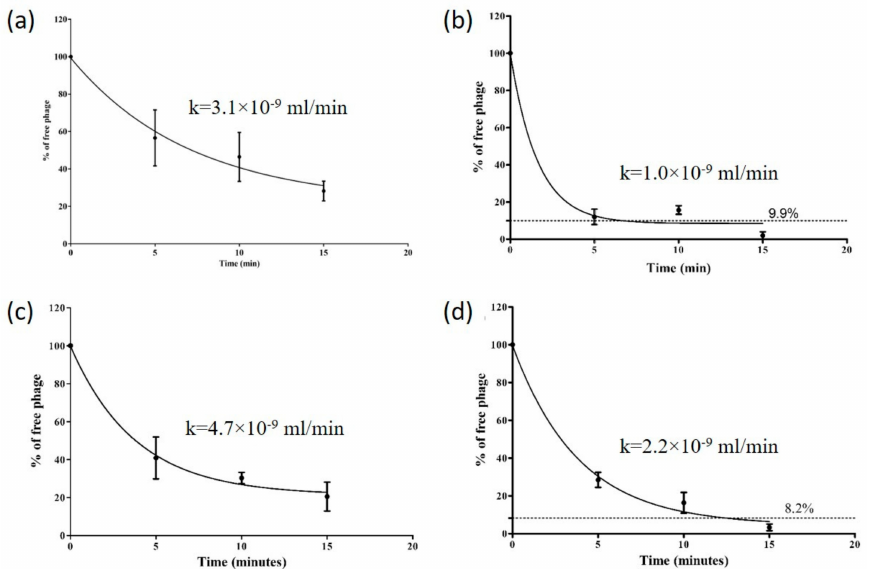
Figure 3. Adsorption curves and adsorption rate constants (k) of Stab20 ( a ), Stab21 ( b ), Stab22 ( c ) and Stab23 ( d ) displayed by the phages when interacting with S. xylosus DD-34 as host bacteria at 37 ◦ C. The data is the average of three experiments carried out on separate days and the average bacterial titers were 7.20 × 10 8 CFU / mL ( a ), 3.93 × 10 8 CFU / mL ( b ), 3.83 × 10 7 CFU / mL ( c ), and 1.20 × 10 8 CFU / mL ( d